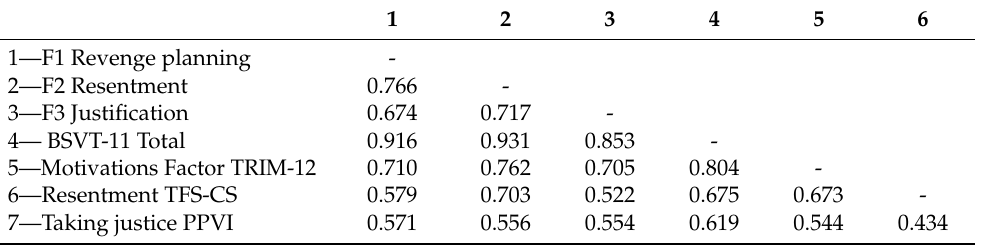
Table 3. Bivariate relationships between the BSVT-11, its factors, and other